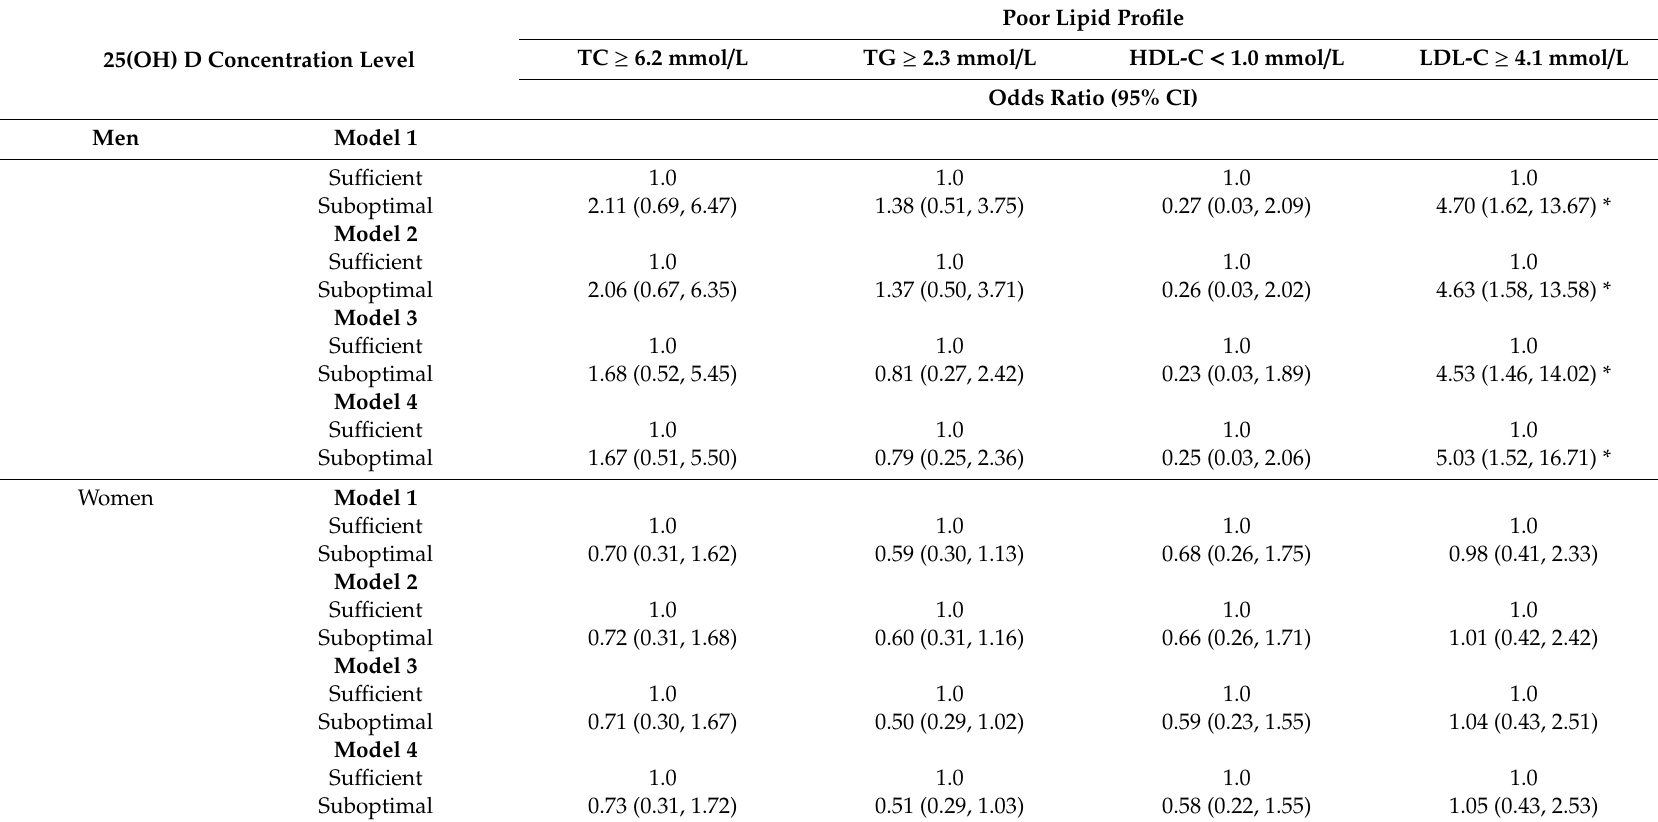
Table 5. Association between 25 (OH) D concentration level and lipid status in men and